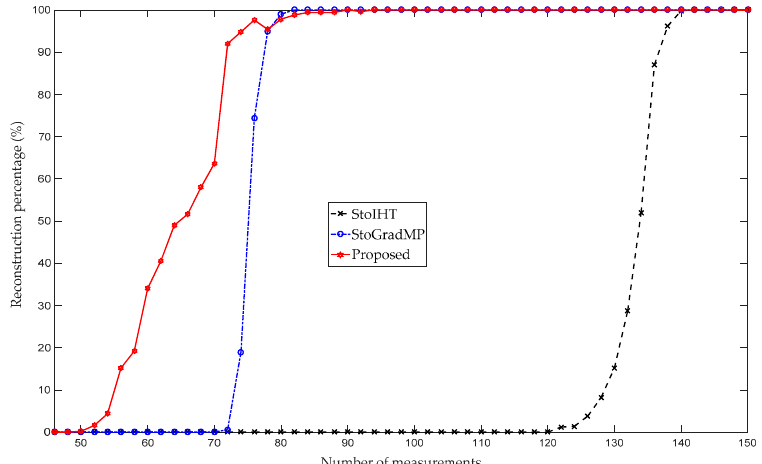
Figure 6. Reconstruction percentages of the different algorithms ( n = 256, K = 24, κ = 0.6, m = 46 : 2 : 150, Gaussian signal).